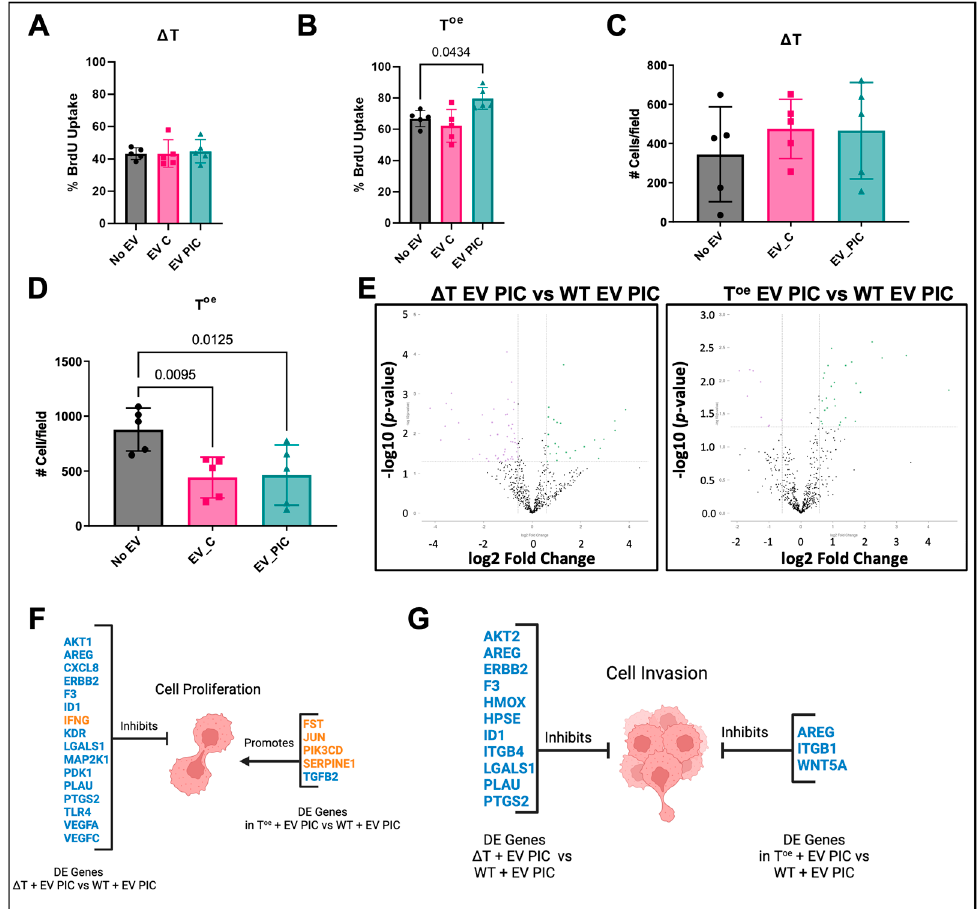
Figure 5. EV effect on PC3ML function is TWIST1 -dependent. EV PIC had no effect on proliferation in Δ T PC3MLs but significantly increased proliferation in T oe PC3MLs ( n = 5) ( A , B ). Invasion was assessed using Matrigel invasion chambers; neither EV C nor EV PIC altered invasion in PC3MLs deficient in TWIST1 , and both EV C and EV PIC reduced invasion in cells overexpressing TWIST1 (EV C, n = 5, p = 0.0070; EV PIC, n = 5, p = 0.0092) ( C , D ). Volcano plots show DE genes with an x-axis indicating DE fold change with a threshold of +/ − 0.58 log2 fold change, p < 0.05. The mRNA transcriptome of either Δ T or T OE cells treated with EV PIC was compared to the transcriptome of WT cells treated with EV PIC. Differential expression (DE) analysis revealed 75 DE genes in Δ T + EV PIC vs. WT + EV PIC and 35 DE genes in T oe + EV PIC vs. WT + EV PIC ( E ). IPA analysis revealed genes deregulated in Δ T + EV PIC vs. WT + EV PIC or T oe + EV PIC vs. WT + EV PIC whose regulation status may impact on observed changes in proliferation ( F ) or invasion ( G ). Genes in blue are downregulated, and genes in orange are upregulated. Table 7. Differentially expressed genes in Δ T + EV PIC versus WT + EV PIC .